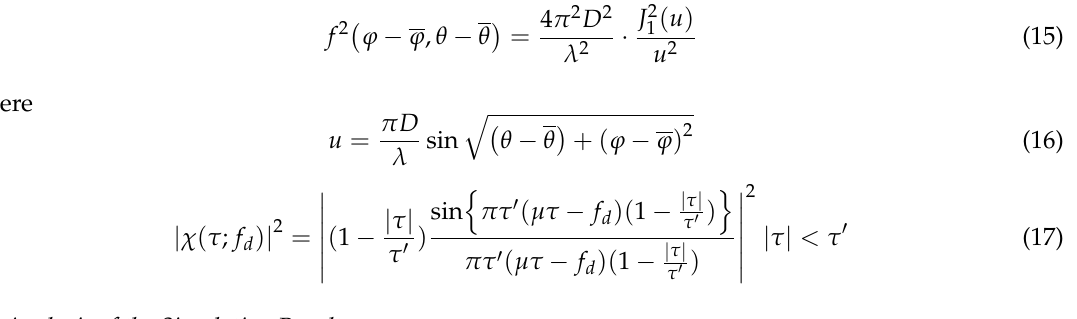
Figure 6. ( a ) The spatial distribution of the precipitation particles model and ( b ) the antenna weighted and distance weighted schemes.